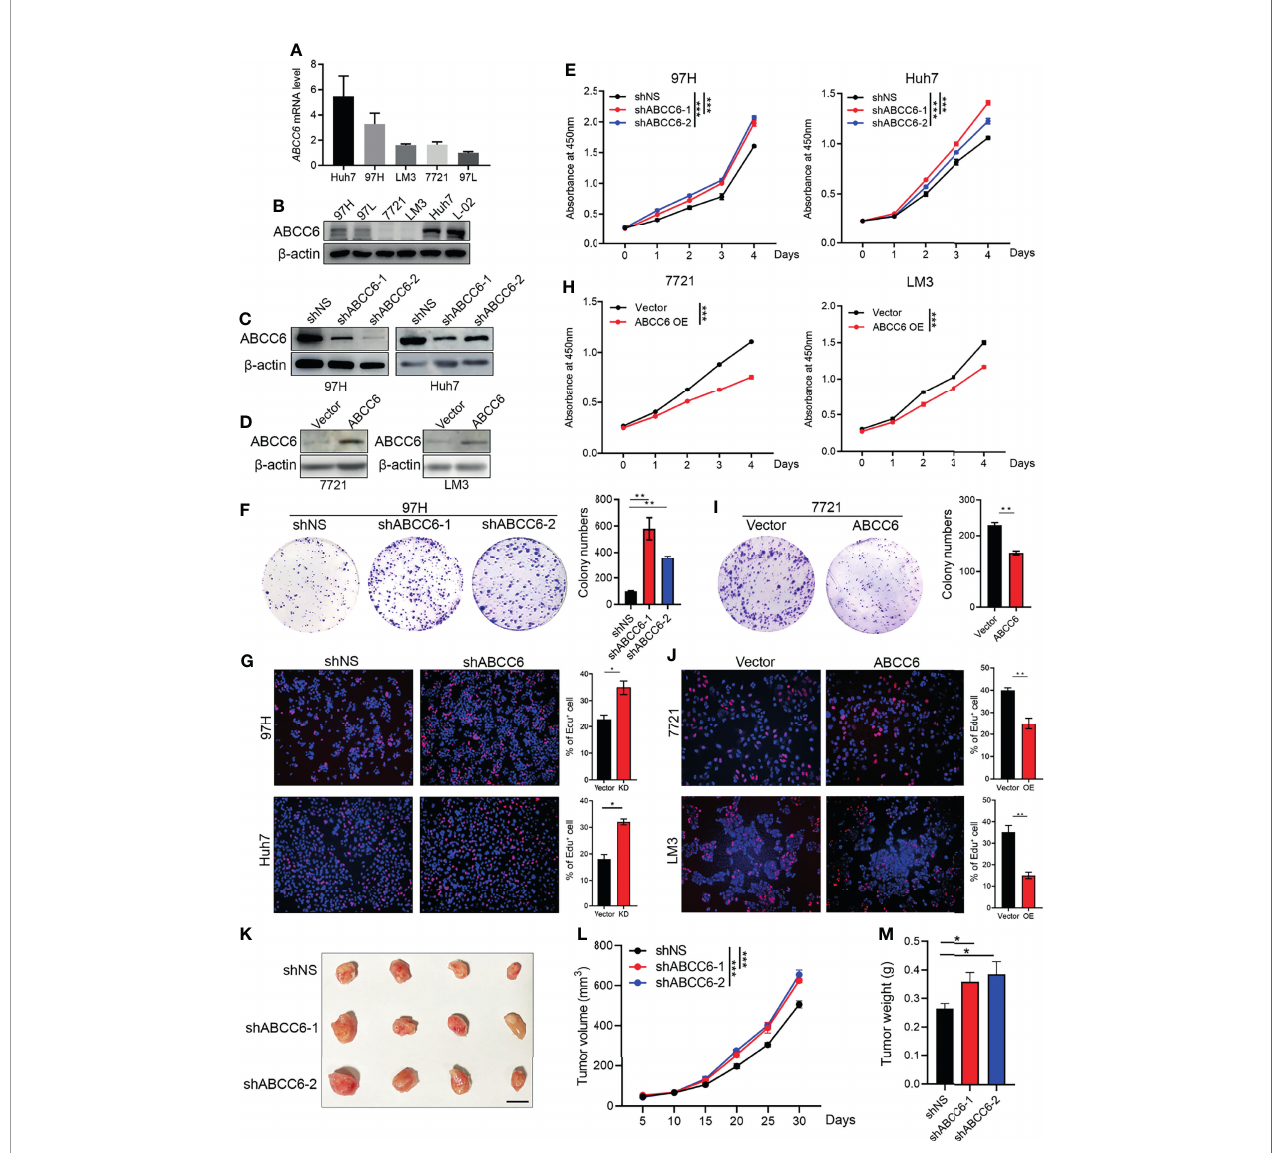
FIGURE 4 | ABCC6 knockdown promotes HCC cell lines proliferation in vitro and in vivo . (A) qPCR analysis showing ABCC6 mRNA expression level in different HCC cell lines. (B) Western blot displaying ABCC6 protein level in different HCC cell lines as well as one normal human hepatic cell line (L-02). (C) Western Blot validating the ABCC6 knockdown ef fi ciency in 97H and Huh7 cell lines. (D) Western Blot validating the ABCC6 overexpression ef fi ciency in 7721 and LM3 cell lines. (E) CCK-8 assay showing the cell proliferation of ABCC6 knockdown 97H and Huh7 cells. (F) Colony formation assay of ABCC6 knockdown 97H cells. (G) Edu incorporation assay showing the effect of ABCC6 knockdown on the cell proliferative ability of 97H and Huh7 cells. (H) CCK-8 assay showing the cell proliferation of ABCC6 overexpression 7721 and LM3 cells. (I) Colony formation assay of ABCC6 overexpression 7721 cells. (J) Edu incorporation assay showing the effect of ABCC6 overexpression on the cell proliferative ability of 7721 and LM3 cells. (K) Images showing the subcutaneous xenograft of ShNS, ShABCC6-1, and ShABCC6-2 97H cells. n=4; The scale bar indicates 1cm. (L) The growth curves of ShNS, ShABCC6-1, and ShABCC6-2 97H cells subcutaneously injected into NSG immunode fi cient mice. (M) The weight of tumors collected from xenograft NSG mouse model implanted with ShNS, ShABCC6-1, and ShABCC6-2 97H cells. Error bars indicate means ± SEM. P -values were determined by two tailed t -test (E – J) and one-way ANOVA (L, M) . * P < 0.05, ** P < 0.01, *** P <